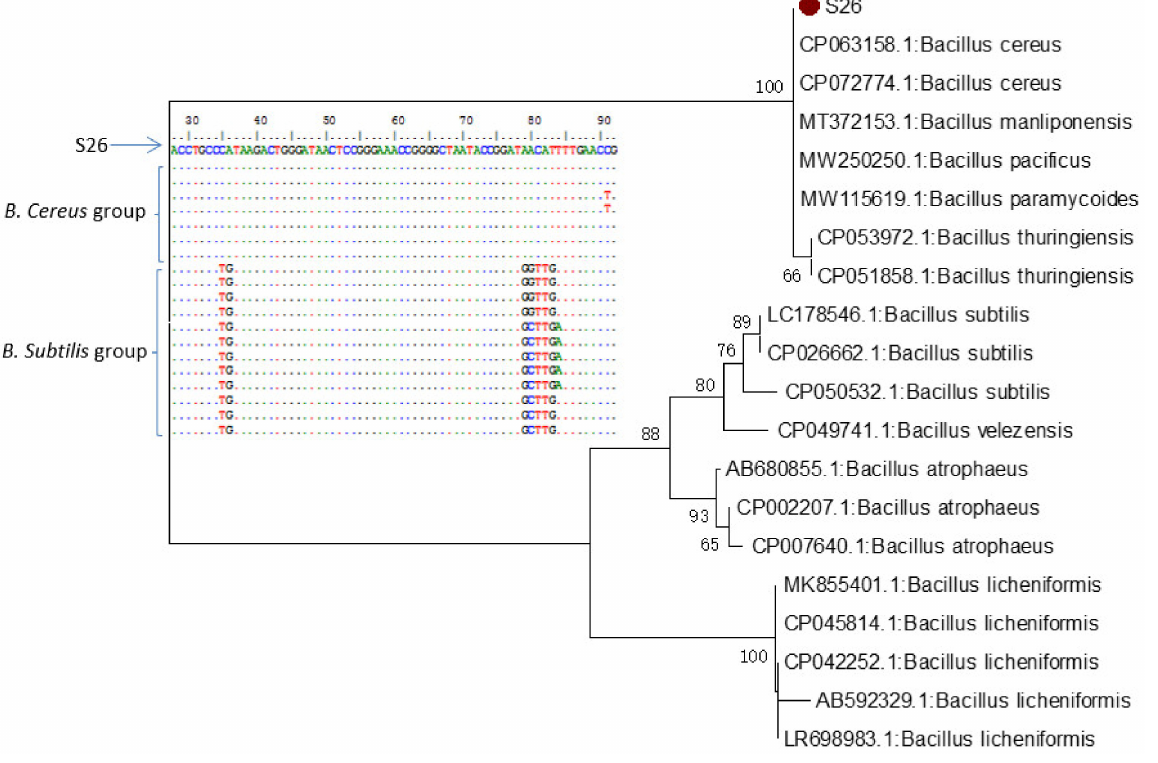
Figure 7. Multiple sequence and neighbor-joining phylogenetic analysis of 16S rRNA gene strain S26 against sequences retrieved from GenBank